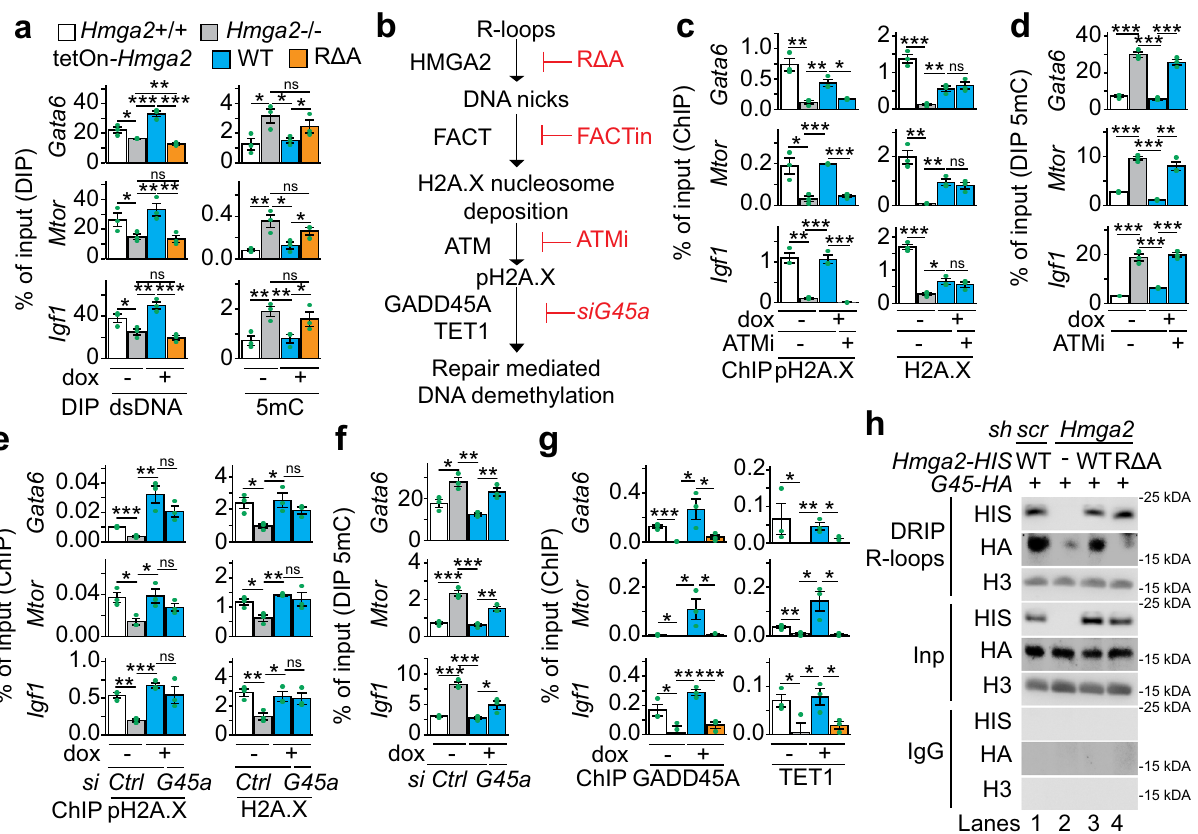
Fig. 7 HMGA2-FACT-ATM-pH2A.X axis is required to solve R-loops and induce DNA demethylation. a DNA immunoprecipitation (DIP) based promoter analysis of selected HMGA2 target genes using antibodies speci fi c for double-stranded DNA (dsDNA) or 5-methylcytosine (5mC) and genomic DNA from Hmag2 + / + , Hmag2 − / − MEF, as well as Hmga2 − / − MEF that were stably transfected with a tetracycline-inducible expression construct (tetOn) for either WT Hmga2-myc-his or the lyase-de fi cient mutant R Δ A Hmga2-myc-his . MEF were treated with doxycycline as indicated. b Schematic representation of the sequential order of events during transcription activation mediated by the HMGA2-FACT-ATM-pH2A.X axis. c ChIP-based promoter analysis of selected HMGA2 target genes using the indicated antibodies and chromatin from MEF treated as in a. In addition, MEF were treated with ATM inhibitor (ATMi; KU-55933) as indicated. d DIP-based promoter analysis as in a, using 5mC-speci fi c antibodies. In addition, MEF were treated with ATMi as indicated. e ChIP-based promoter analysis of selected HMGA2 target genes using the indicated antibodies and chromatin from MEF treated as in a. In addition, MEF were transfected with control (Ctrl) or Gadd45a -speci fi c small interfering RNA (siRNA) as indicated. f DIP-based promoter analysis as in a, using 5mC-speci fi c antibodies. In addition, MEF were transfected with Ctrl or Gadd45a -speci fi c siRNA as indicated. g ChIP-based promoter analysis of selected HMGA2 target genes using the indicated antibodies and chromatin from MEF treated as in a . h WB analysis using antibodies speci fi c for HIS-tag, HA-tag and H3 after DRIP using the antibody S9.6 41 and chromatin isolated from MLE-12 cells that were stably transfected either with a control (scramble, scr ) or an Hmga2 -speci fi c short hairpin DNA ( sh ) construct and transiently transfected with WT Hmga2-myc-his or the lyase-de fi cient mutant R Δ A Hmga2-myc-his and Gadd45 -HA as indicated. Representative image from two independent experiments. Input (Inp), 5% of IP starting material; immunoglobulin G (IgG), negative control. In all bar plots, data are shown as means ± s.e.m. ( n = 3 biologically independent experiments); asterisks, P -values after one-tailed t -test, *** P ≤ 0.001; ** P ≤ 0.01; * P ≤ 0.05; ns, non-signi fi cant. See also Supplementary Fig. 8. Source data are provided as a Source Data fi les 01 and